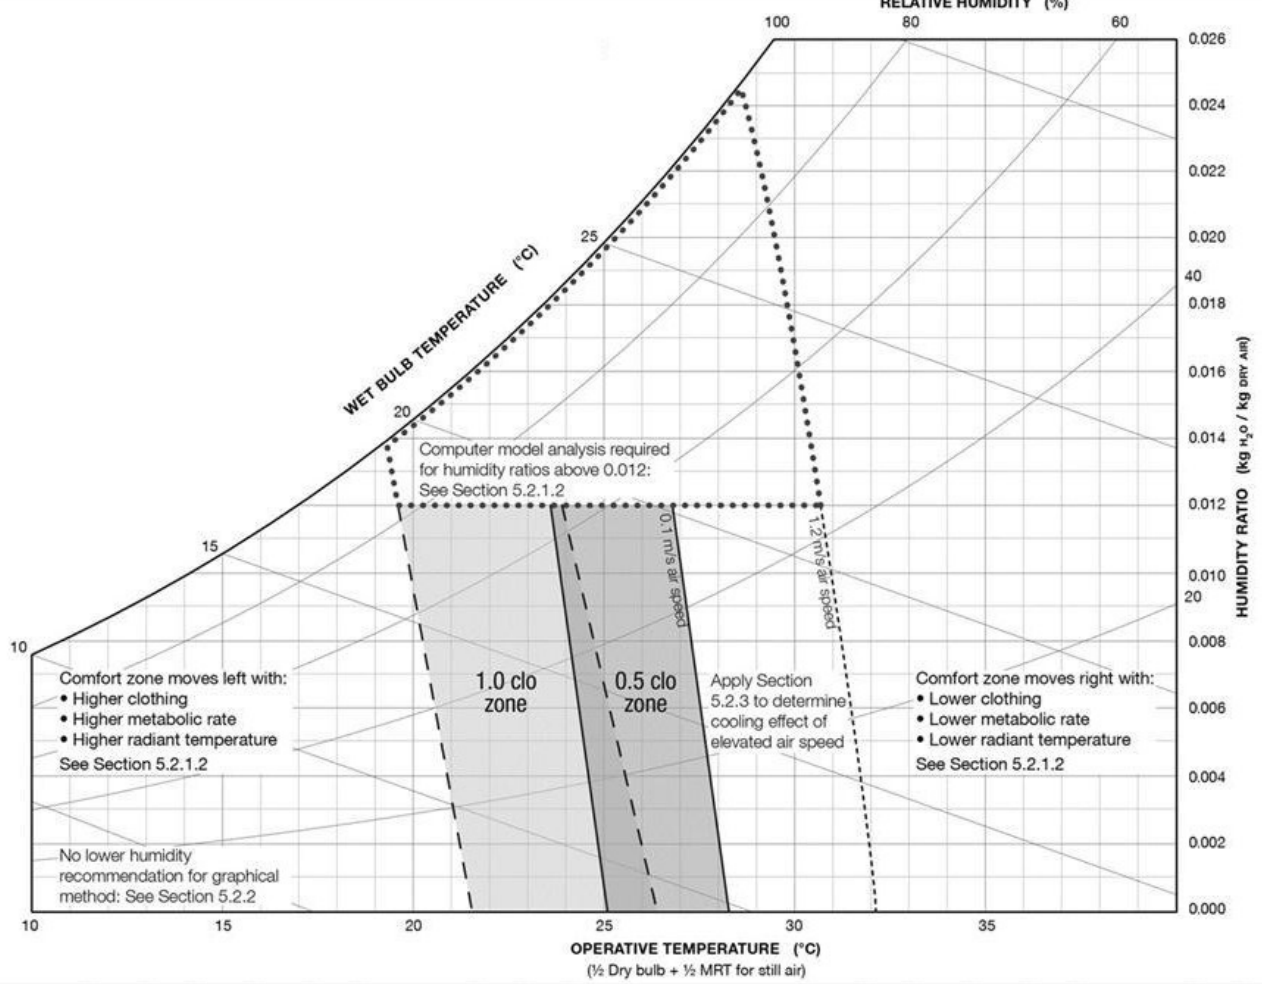
Figure 7. A standard psychrometric chart for system design